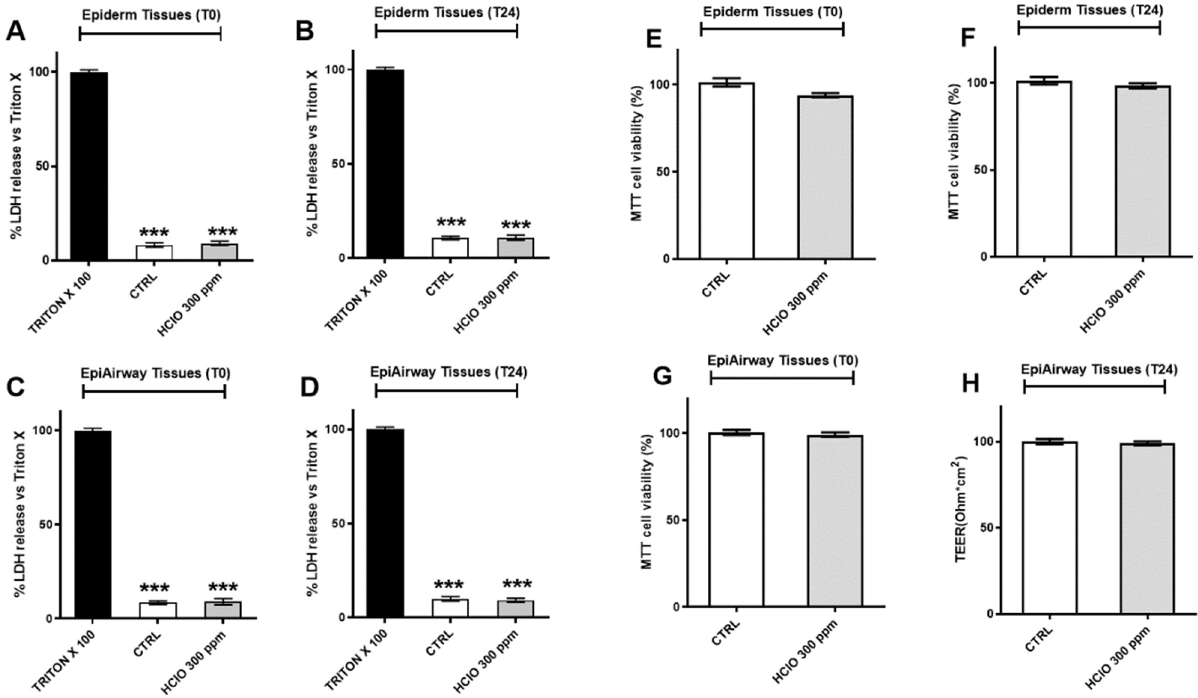
Figure 7. Effects of HOCl nebulization on Epiderm and Epiairway tissues. Left panels ( A – D ) Cytotoxicity evaluation by lactate dehydrogenase release in reconstructed human epidermis tissues (RHE) and Epiairway tissues maintenance media immediately after or after 24 h from the exposure to 300 ppm HOCl measured by an enzymatic assay. Right panels ( E – H ) cytotoxicity evaluation by MTT assay in reconstructed human epidermis tissues (RHE) and Epiairway tissues immediately after or after 24 h from the exposure to 300 ppm HOCl. Data are presented as mean ± SEM of four different experiments. *** p <